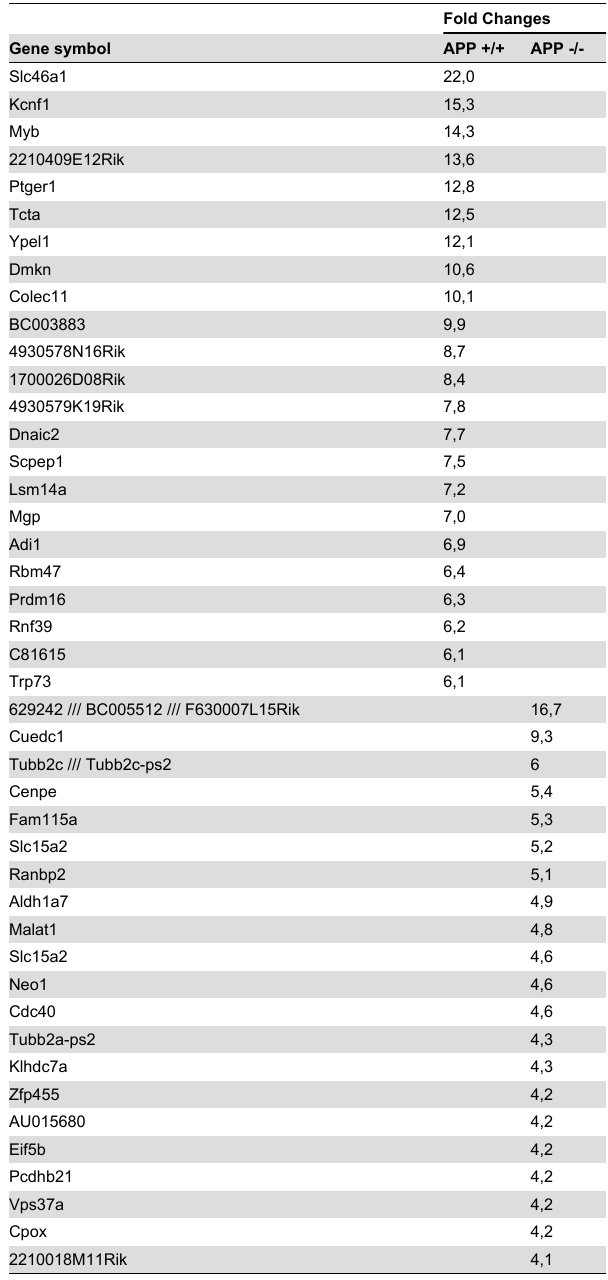
Table 1. Microarray